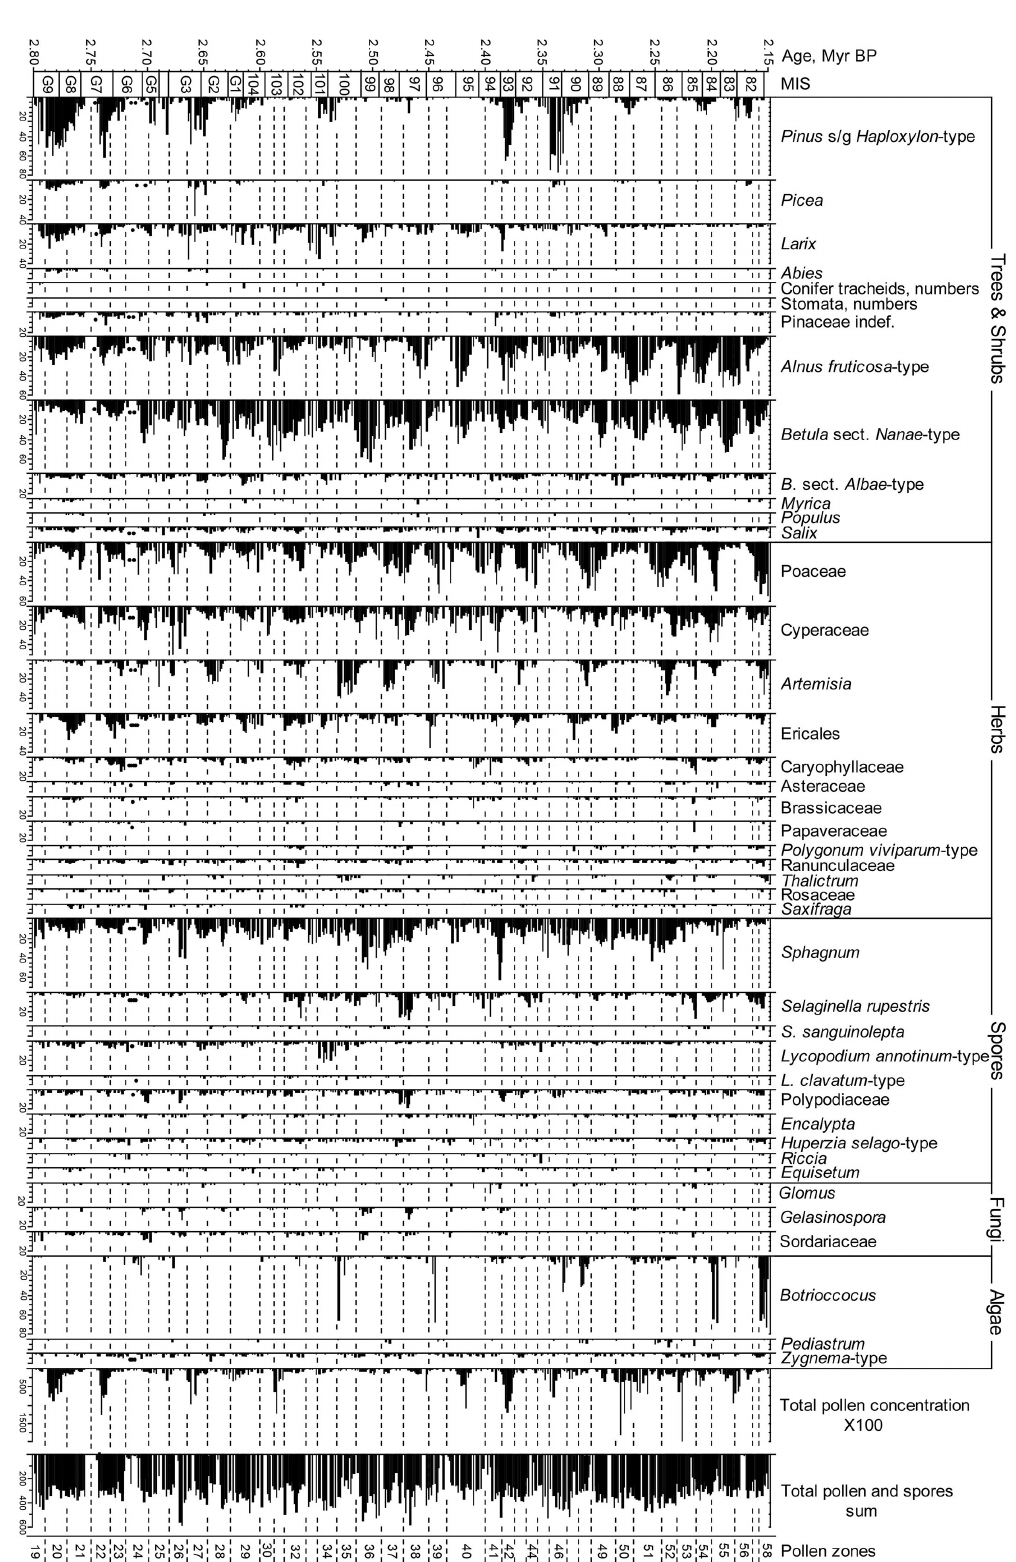
Figure 3c. Percentage pollen, spore, and non-pollen-palynomorph diagram. The most common pollen and spores types between ca. 2.8 and 2.15Myr